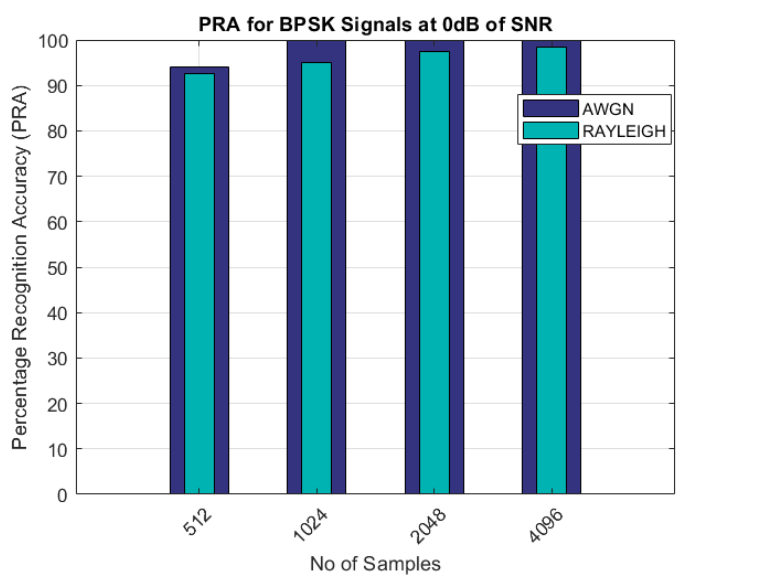
Figure 3. PRA for BPSK signals.